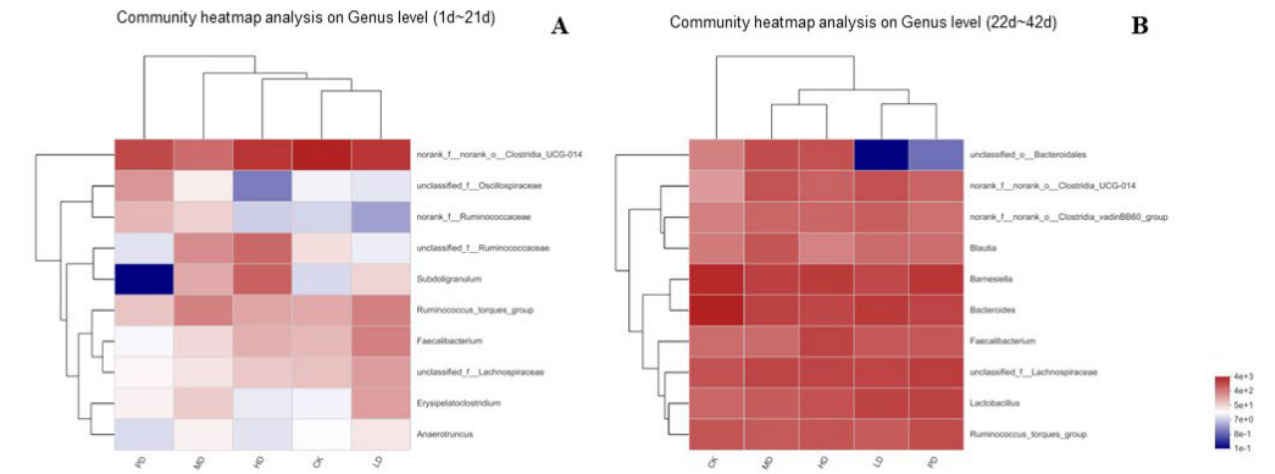
Figure 11. Heat map of the composition of each microbiota at the genus level ( A ): the early stage (1~21d), ( B ): the late stage (22~42d).